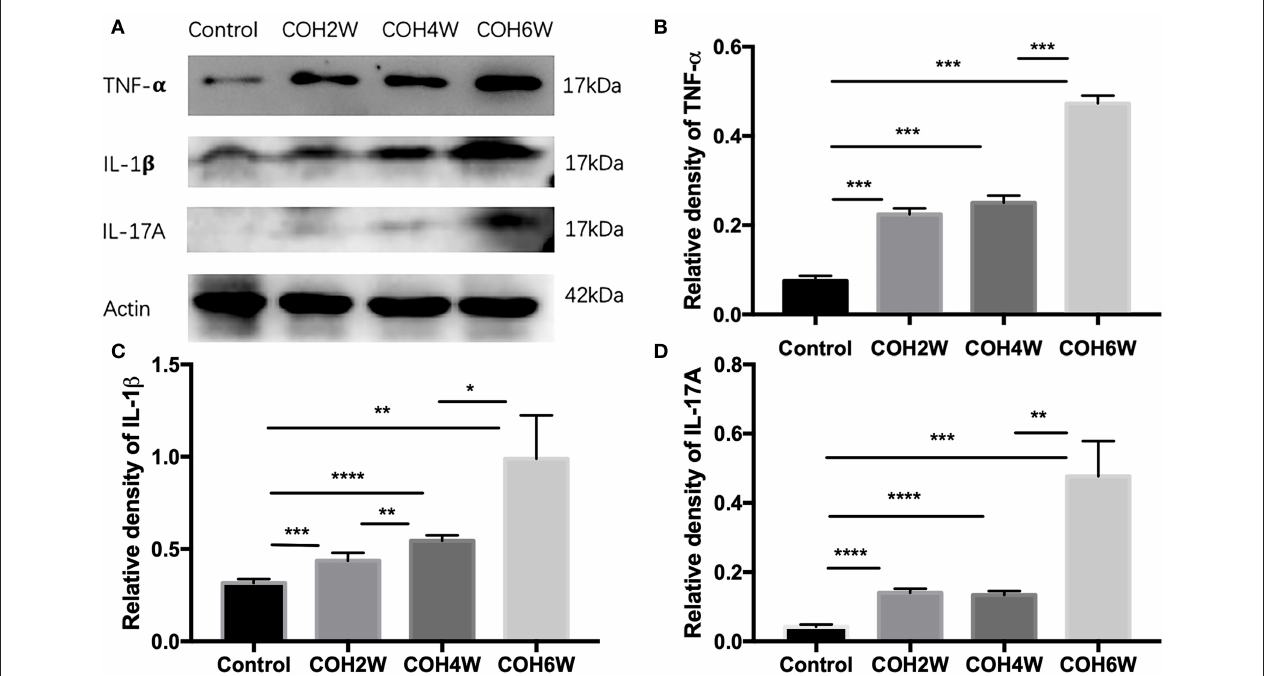
FIGURE 4 | Western blotting of retinal expressions of inflammatory factors. (A) Bands of western blotting. (B – D) Quantitative analysis of western blotting gray values; TNF- α , IL-1 β , and IL-17A protein expression increased gradually from the second week to the sixth week after COH. Data were analyzed using one-way ANOVA followed by Tukey’s post hoc test (* p < 0.05, ** p < 0.01, *** p < 0.001, and **** p < 0.0001). N = 20 mice (control group: 5 mice; hydrogel injection group: 15 mice). Bars represent mean ±